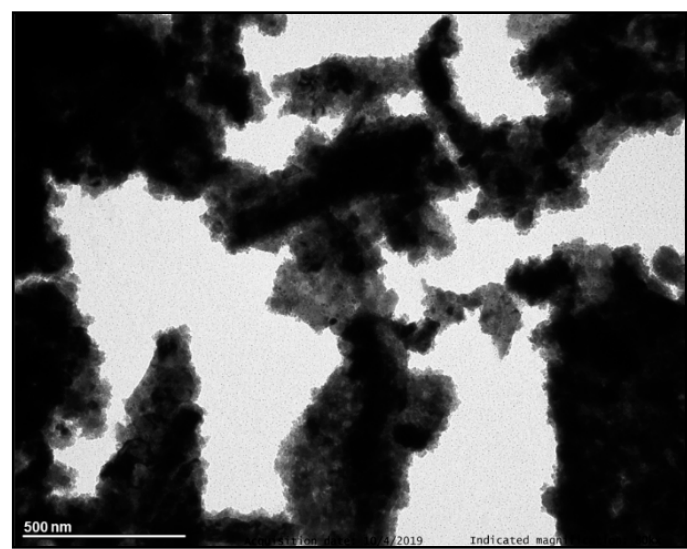
Figure 4. TEM image of Y 2 O 3 : Pr 3+ NCs prepared by combustion method after calcination at 900 °C for 4 h.